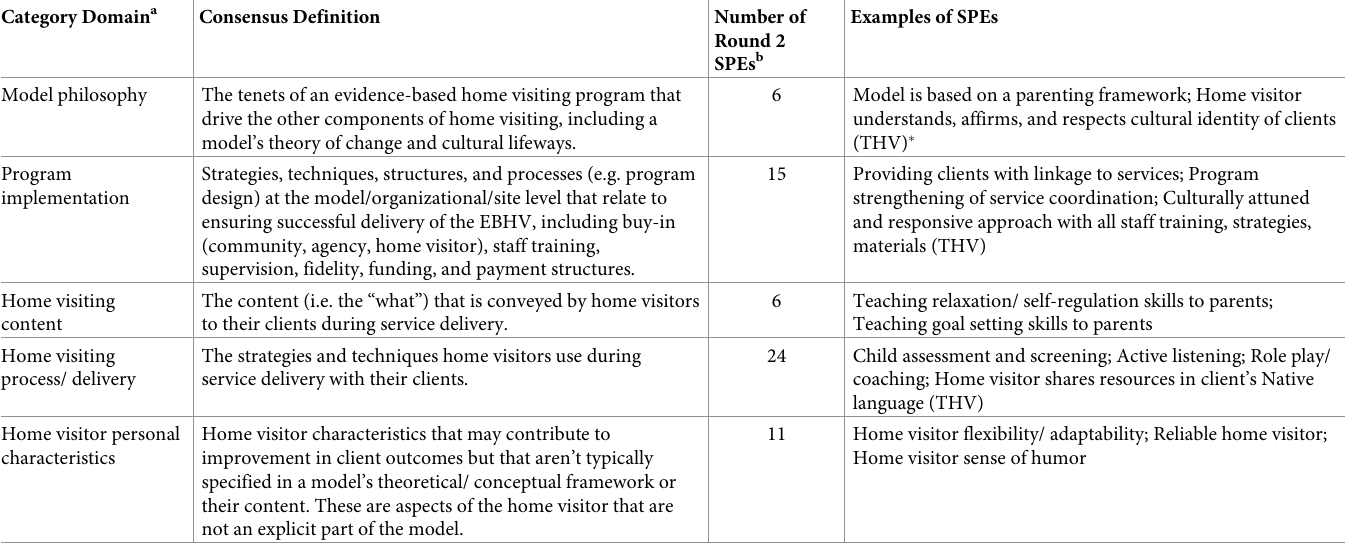
Table 1. Frequency of SPEs � by category